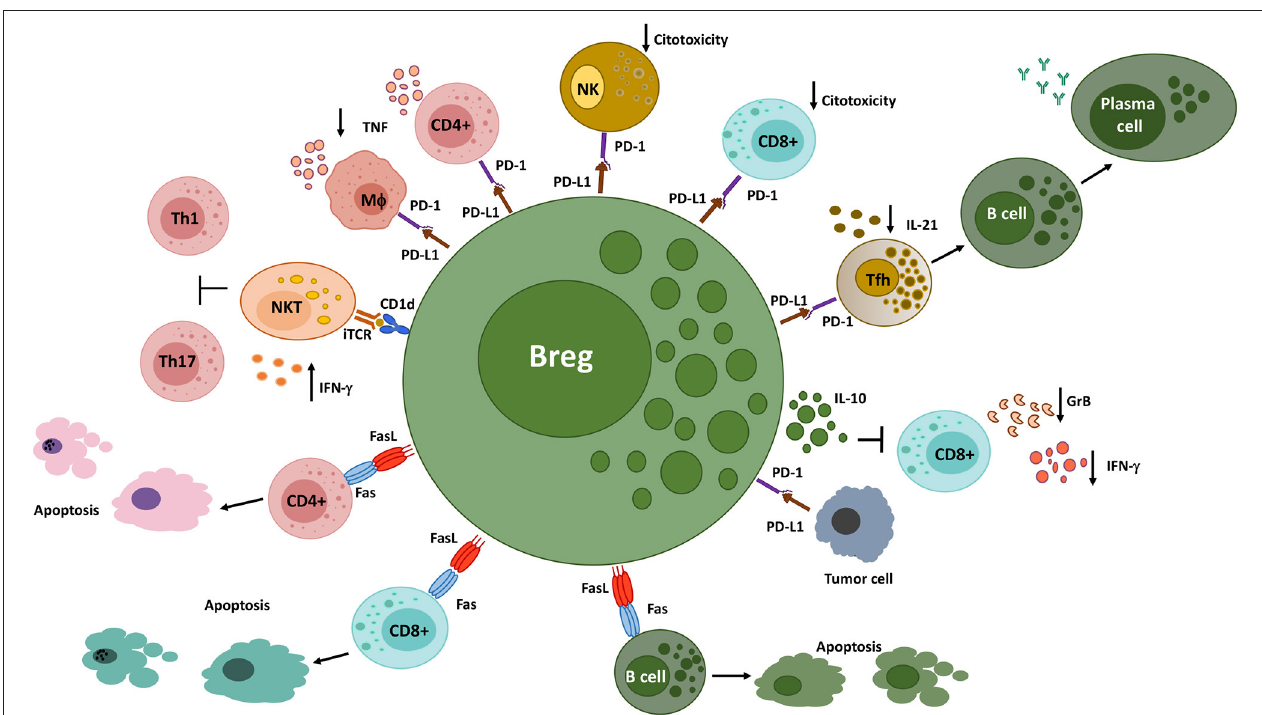
FIGURE 2 | Different Breg populations utilize cell surface-expressed molecules to suppress immune responses. Bregs interact with NKT cells via CD1d, inducing the production of IFN- γ , which inhibits Th1 and Th17 responses in a murine arthritis model. PD-L1 + Bregs decrease the production of pro-inflammatory cytokines by PD-1-expressing CD4 + T cells and macrophages and the cytotoxic functions of PD-1-expressing CD8 + T cells and NK cells. In addition, they interact with PD-1-expressing follicular helper T cells, leading to an inhibition of humoral immune responses. On the other hand, PD-L1 expressed on tumor cells engage PD-1 + Bregs, triggering the production of IL-10 and the suppression of anti-tumor responses. Finally, FasL + B cells induce apoptosis on Fas-expressing CD4 + and CD8 + T cells, as well as on B cells. GrB, Granzyme B; iTCR, invariant T cell receptor; M Φ , Macrophage; NK, Natural killer cell; NKT, Natural killer T cell; Tfh, Follicular helper T